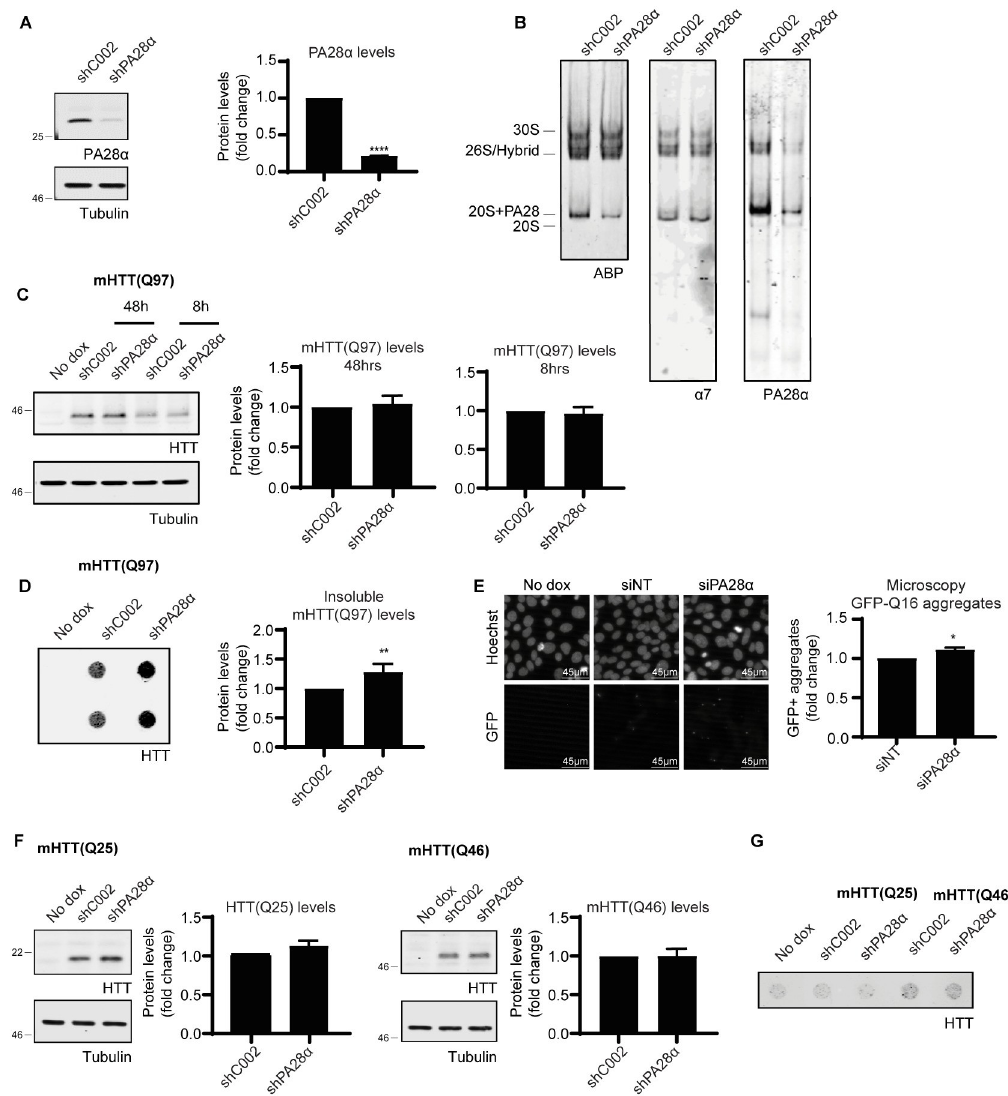
Fig 5. PA28 αβ silencing increases mHTT aggregation in ST Hdh cells. (A) ST Hdh cells treated with shPA28 α show decreased PA28 α protein levels. Data are normalized to shC002 treated cells and shown as mean ± SEM (n = 6). One sample t- test; ���� p < 0.0001. (B) Native PAGE of PA28 αβ activated proteasomes levels in ST Hdh cells treated with shPA28 α as shown by ABP labeling and immunoblotting. (C) Effects ofPA28 α silencing on soluble mHTT(Q97) levels in ST Hdh cells by SDS-PAGE. HTT expression was normalized to shC002 treated cells and shown as mean ± SEM (n = 3). One sample t-test; mHTT(Q97) 48h p = 0.4515, mHTT(Q97) 8h p = 0.6969. (D) Filtertrap analysis to showthe effects of shPA28 α treatment in ST Hdh cells on mHTT(Q97) aggregation. Data are normalized to shC002 treated cells and shown as mean ± SEM (n = 7). One sample t-test; p = 0.0093. � p < 0.05; �� p < 0.01 (E) mHTT(97) aggregation analyzed by microscopy in ST Hdh cells expressing dox inducible mHTT(Q97)exon1-IRES-GFP-Q16 upon treatment with siNT or siPA28 α . Data are normalized to siNT treated cells and shown as mean ± SEM (n = 4). One sample t-test; p = 0.0295. (F) Effects of transduction with shPA28 α on soluble levels of wildtype HTT(Q25) and on shorter polyQ-expanded mHTT(Q46) fragments. HTT expression was quantified and normalized to shC002 treated cells and shown as mean ± SEM (n = 3). One sample t-test; HTT(Q25) p = 0.2857, mHTT(Q46) p = 0.9331. (G) Effects of PA28 α silencing on HTT(Q25) and mHTT(Q46)